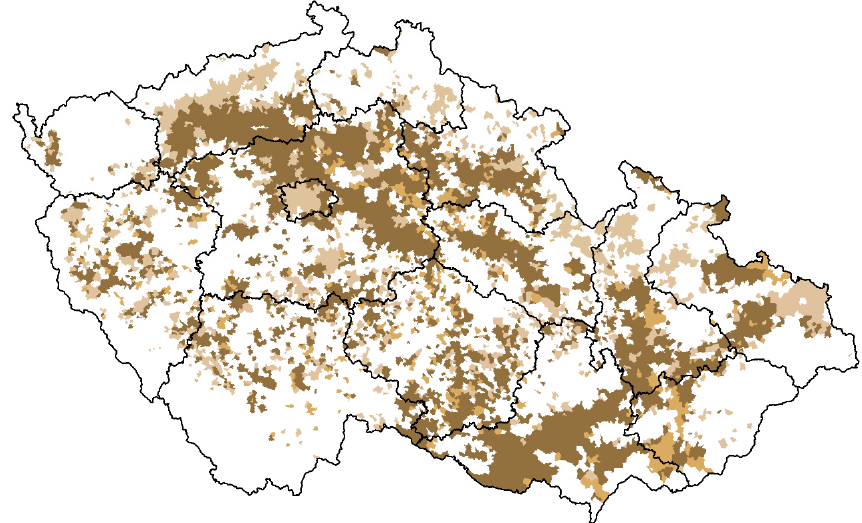
Figure 4. Changing distribution of arable land: BTUs that lay in the concentrated half (C) both in 1845 and 2010 (dark brown), BTUs that entered C between 1845 and 2010 (medium brown) and BTUs that left C between 1845 and 2010 (light brown). Source: own calculation, LUCC Czechia database.